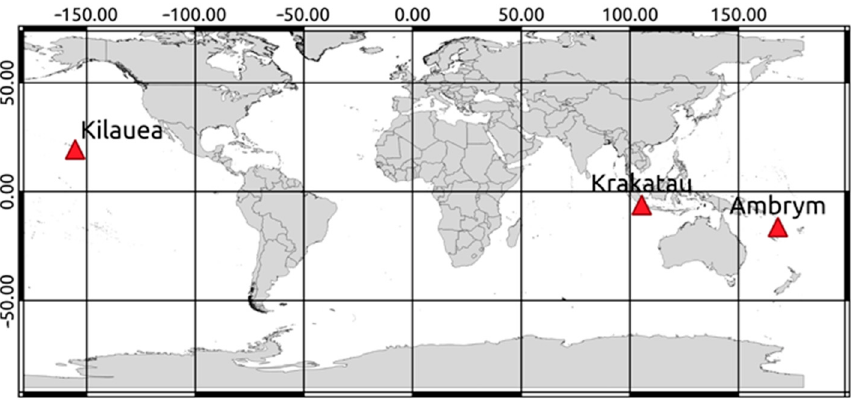
Figure 1. Geographic location of the Kilauea (HI, USA), Krakatau (Indonesia) and Ambrym (Vanuatu) volcanoes analyzed in this study.